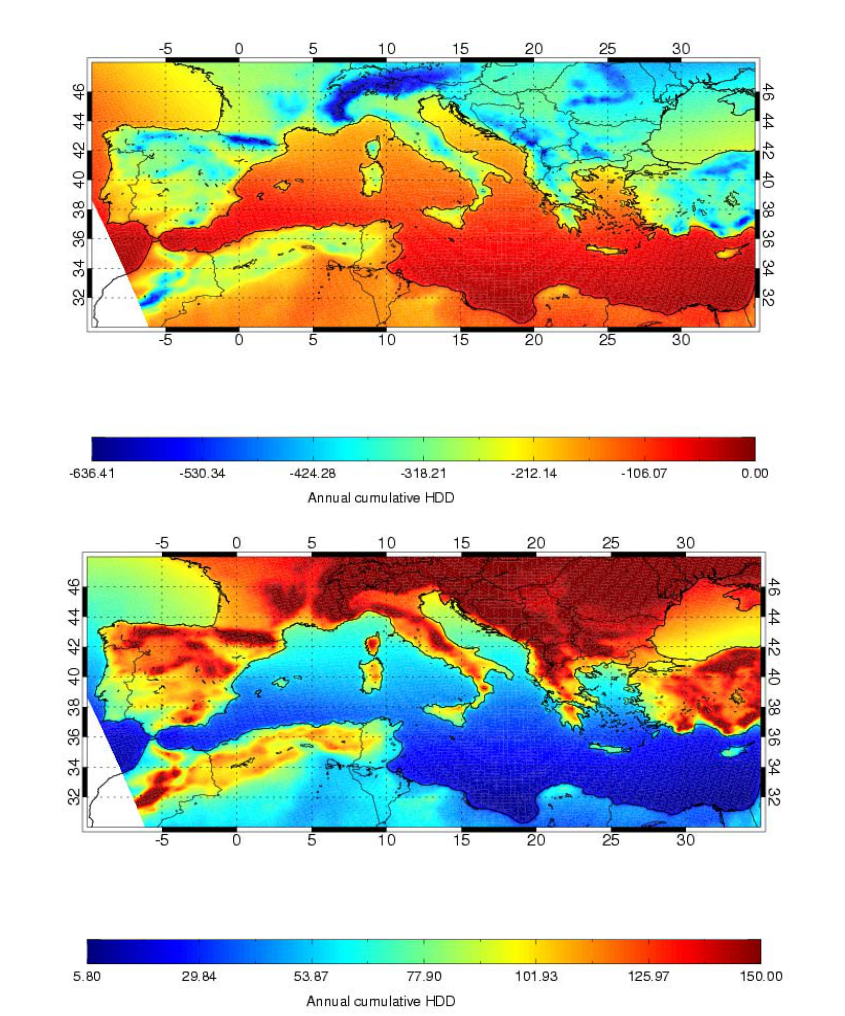
Figure 5. Changes in annual cumulative HDD between future and control period (top) and standard deviation of the changes (bottom).